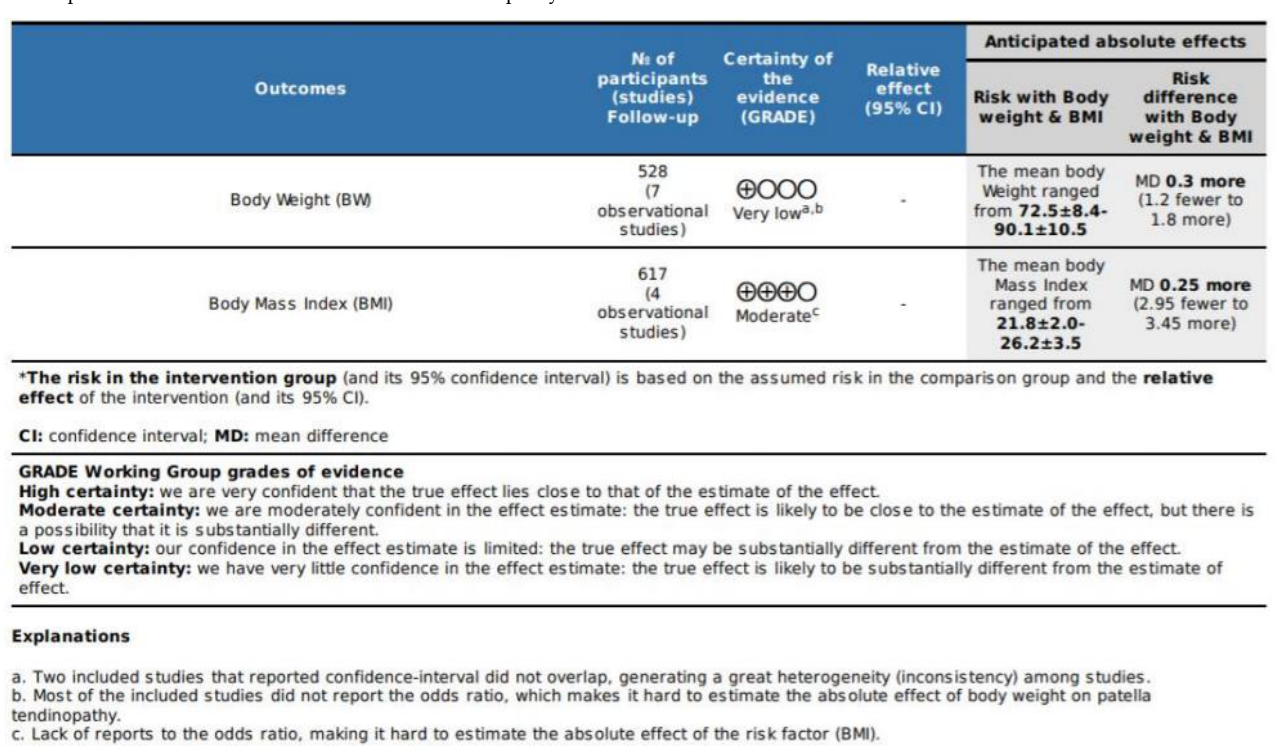
Figure 2. GRADE Summary of Findings Table. a. Two included studies that reported confidence intervals did not overlap, generating a great heterogeneity (inconsistency) among studies. b. Most of the included studies did not report the odds ratio, making it hard to estimate the absolute effect of body weight on patellar tendinopathy. c. Lack of reports on the odds ratio, which makes it hard to estimate the absolute effect of the risk factor (BMI).